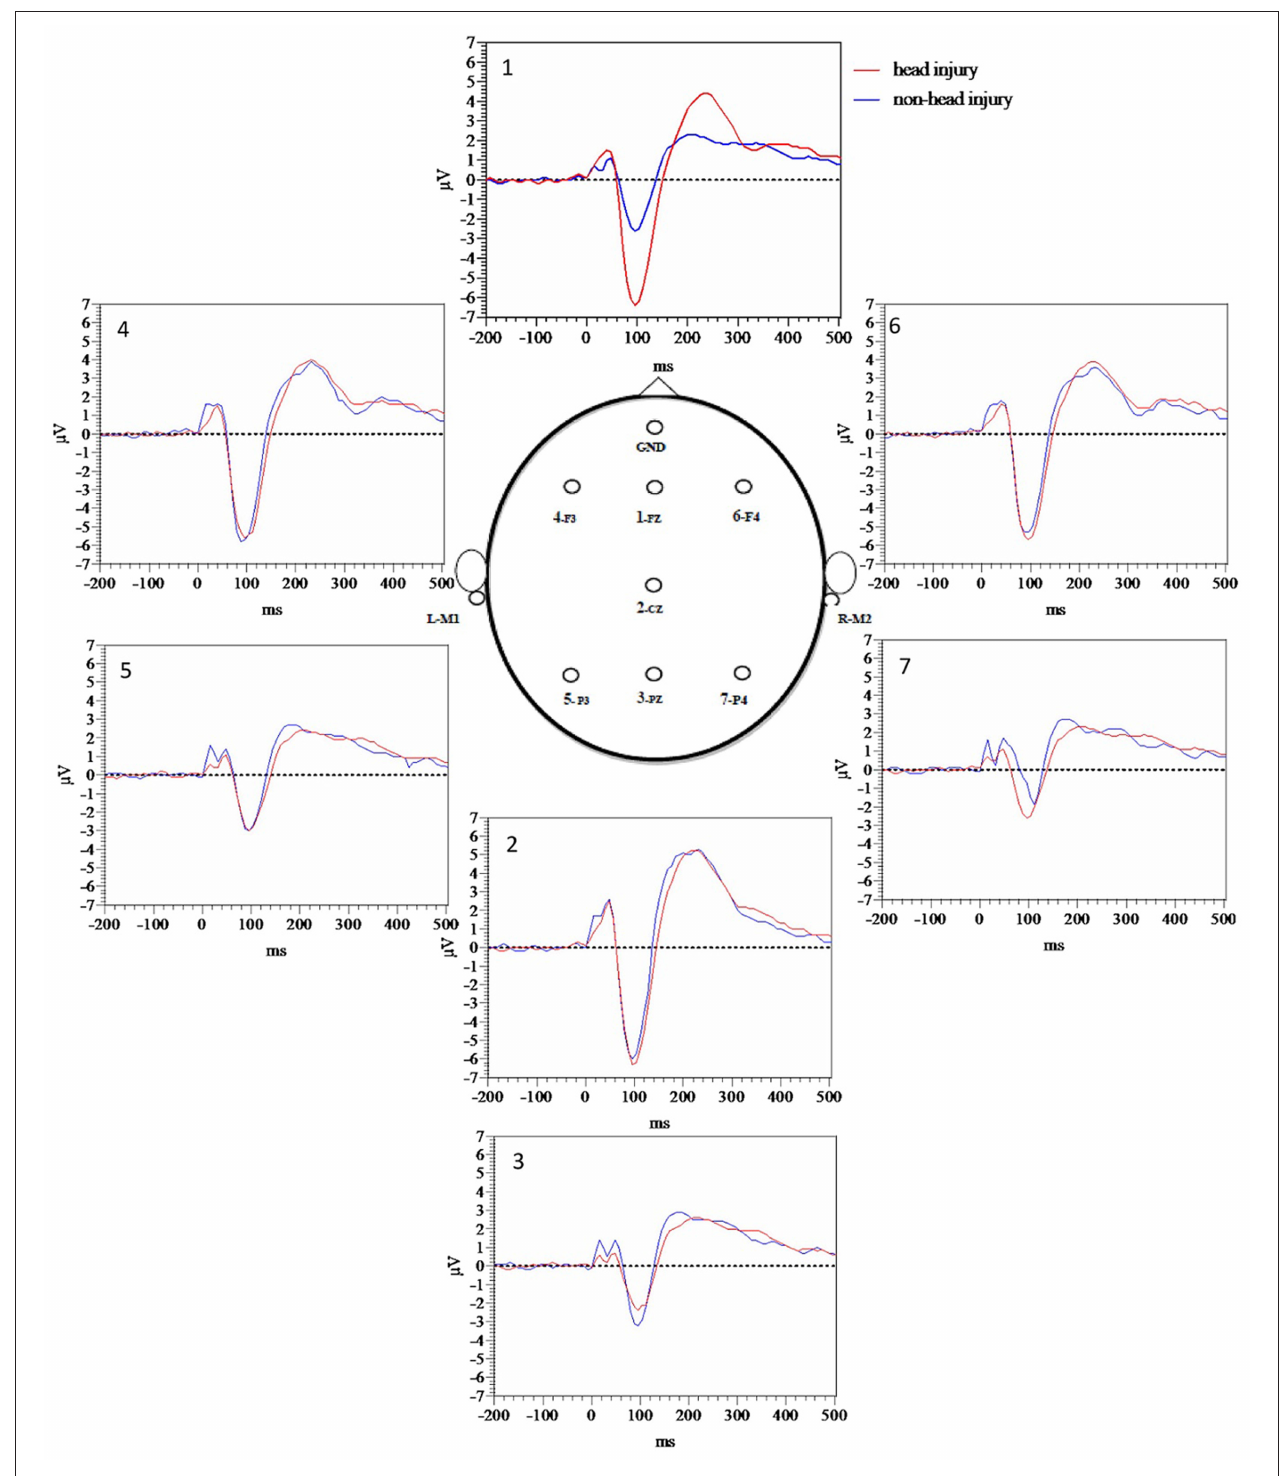
FIGURE 2 | Standard tone grand average waveforms for each